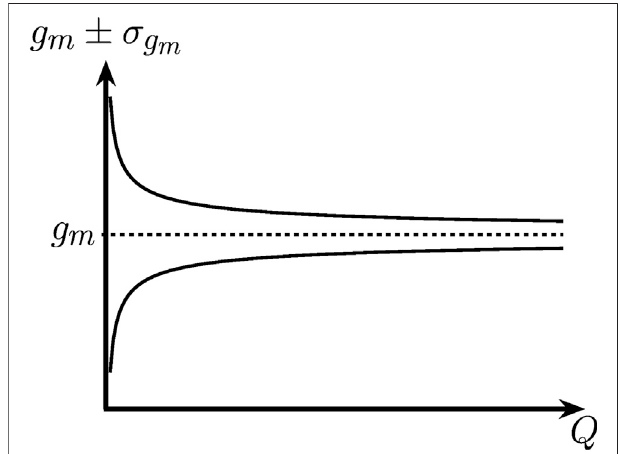
FIGURE 3 | Sketch of the m ’ the component of Capon ’ s estimator and the corresponding 1 σ -error subject to the sample size Q . The error declines $$ √ as 1 / Q